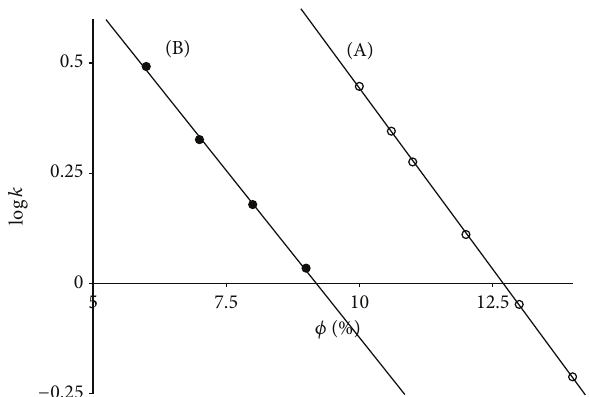
Figure 2: Dependence of Cy3Glu retention upon acetonitrile volume fraction ( 𝜙 , %) in System 1 (A) and System 2 (B). Chromatographic column: 4.6 × 250 mm Symmetry C 18 .